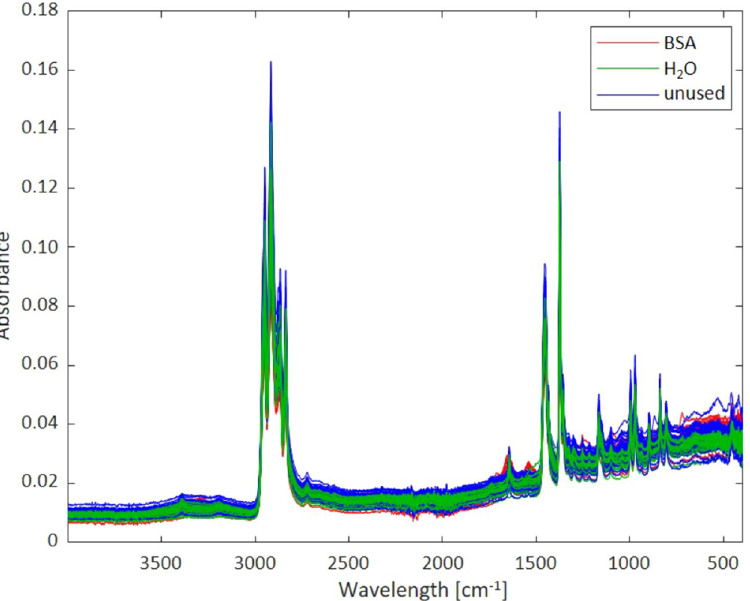
Figure 2. Exemplary characteristic evanescent field absorbance spectra of protective face masks obtained via IR-ATR spectroscopy. Unused masks (blue), masks sprayed with BSA (red), and masks sprayed with water